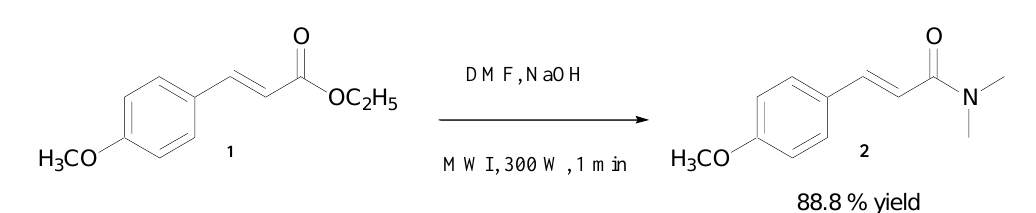
Figure 3. TLC monitoring of Product of reaction (eluent n-hexane-EtOAc 3:2). 1 : Amide product ( 5 ), 2 : Hydrolysis product ( 6 ), 3 : EPMC ( 1 )